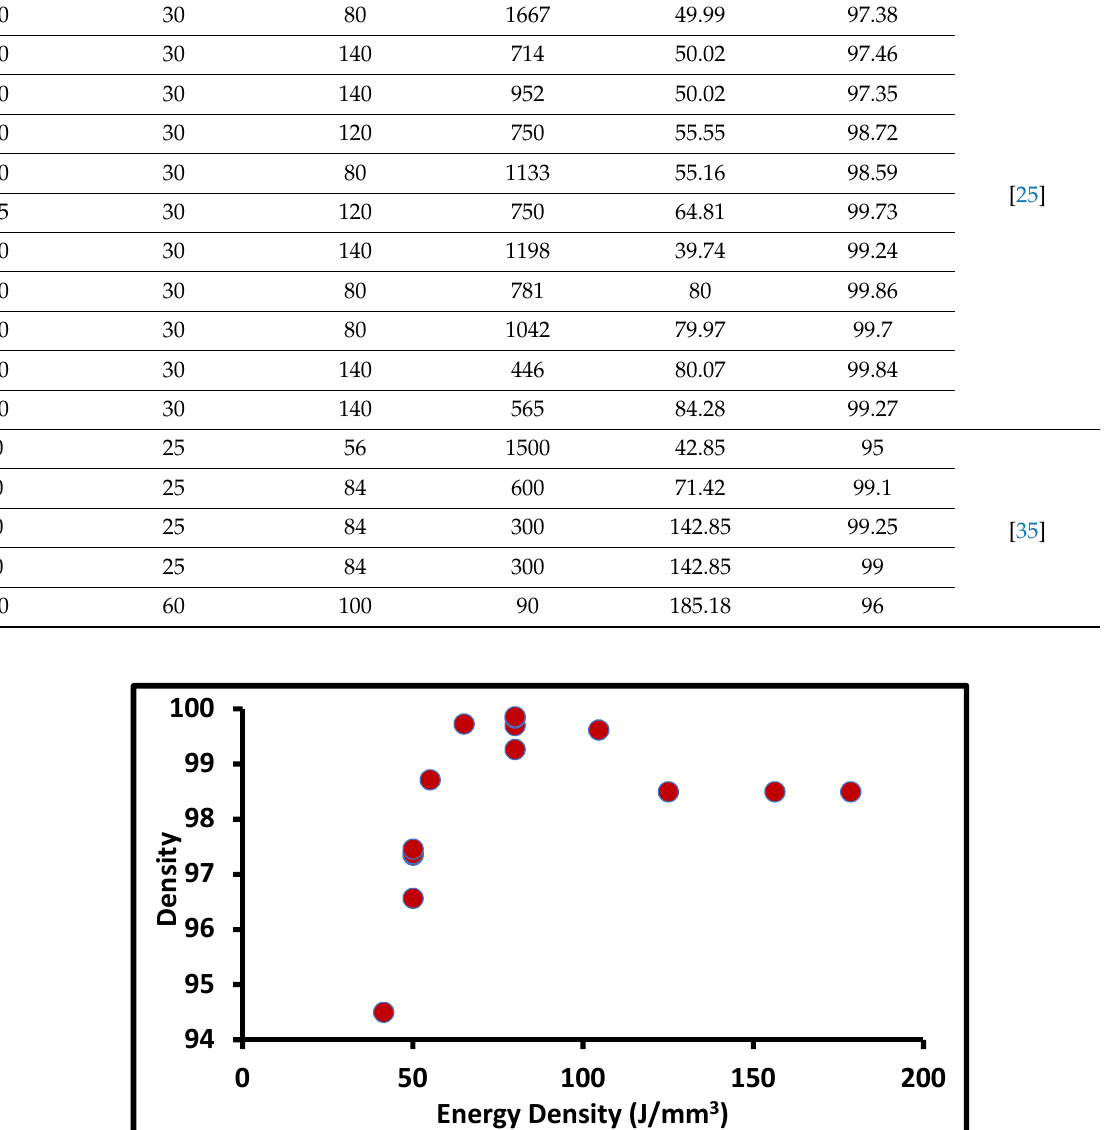
Figure 11. The density of the build part at a different energy density.